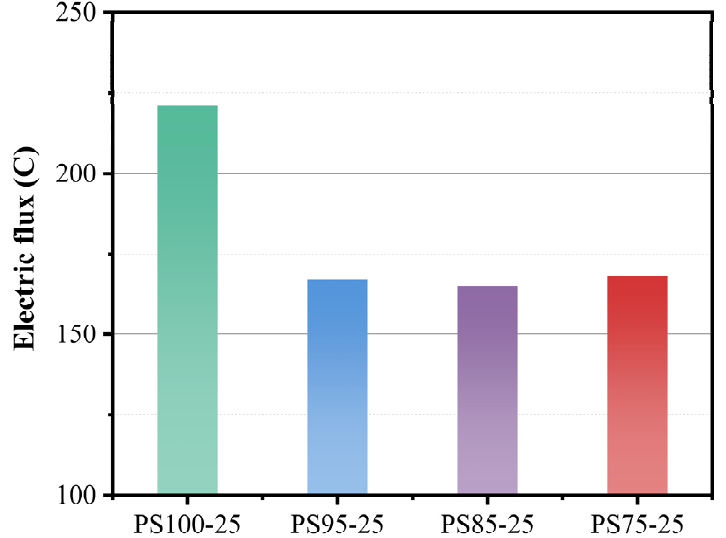
Figure 6. The electric fluxes of WUFA-PS with different WUFA substitutions and PS-based geopoly- mer mortars.